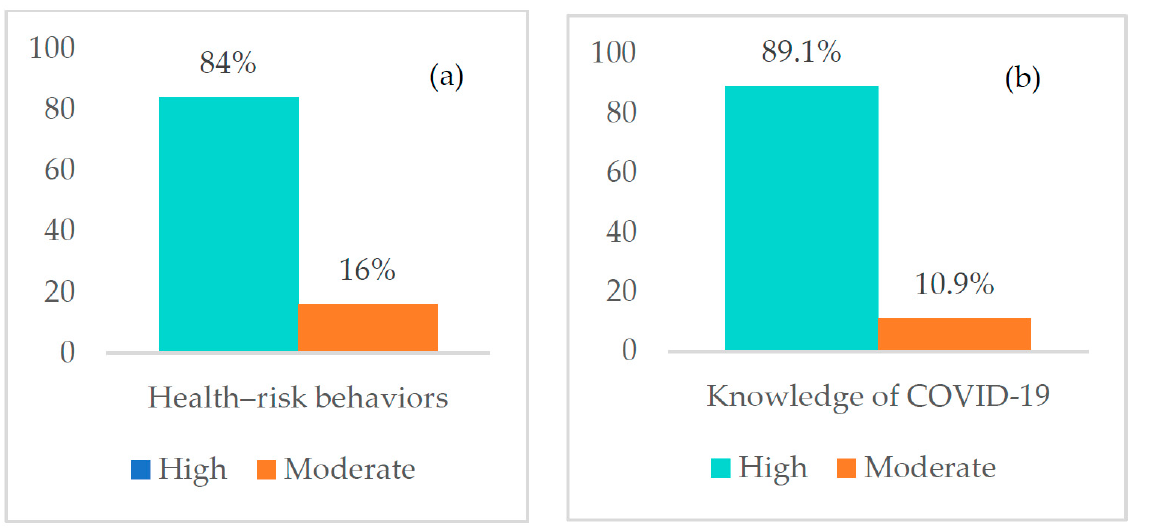
Figure 1. Participant levels of ( a ) health ‐ risk behavior levels and ( b ) knowledge about COVID ‐ 19.